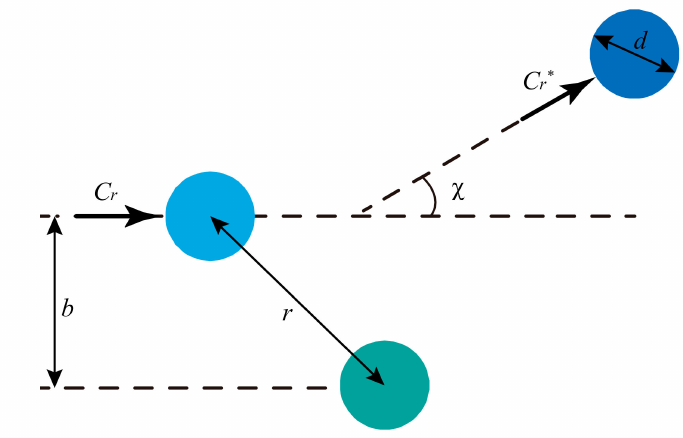
Figure 2. Binary scattering diagram in the fixed scattering center frame of